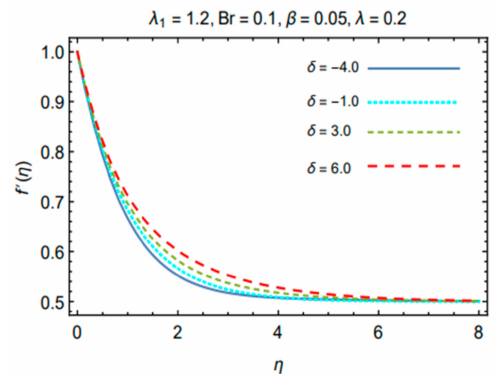
Figure 3. Variation in f (cid:48) ( η ) against δ .